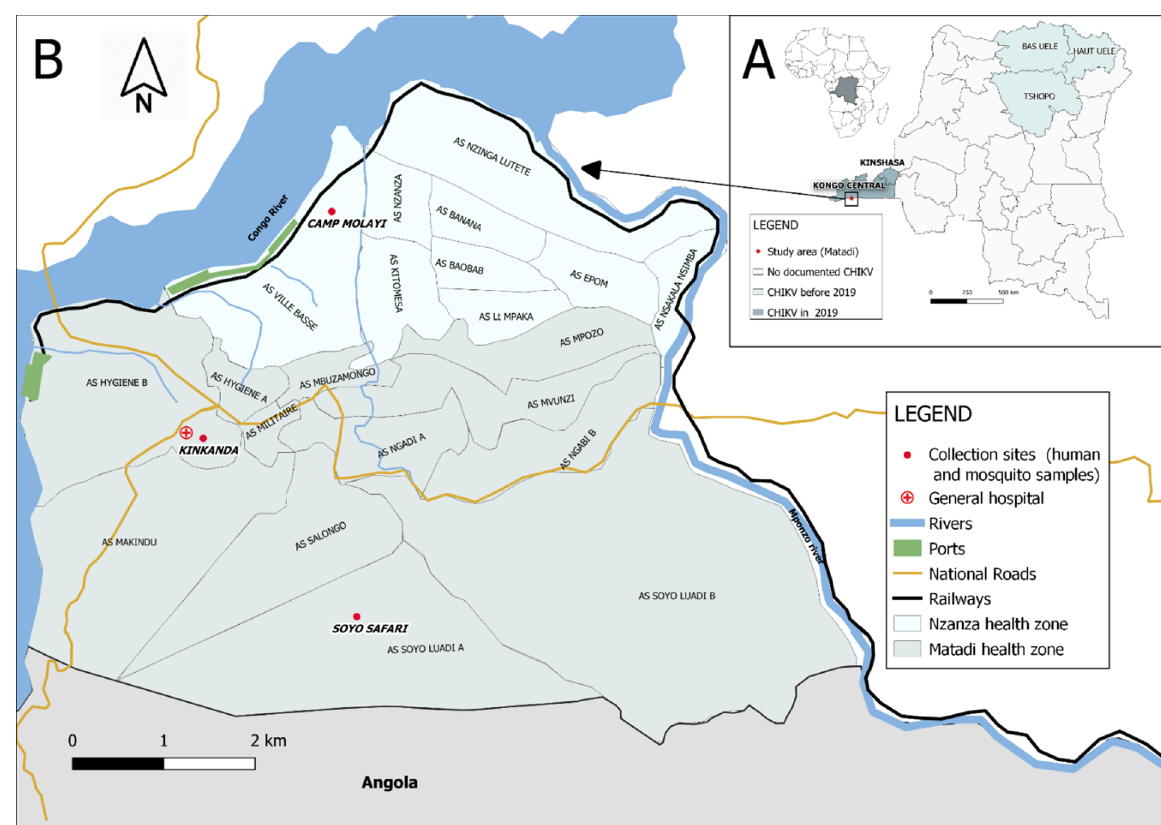
Figure 1. ( A ) Map of the Democratic Republic of the Congo (DRC) indicating the provinces where chikungunya virus outbreaks have occurred up to 2019 (including the Matadi study area indicated with the red dot). ( B ) Map of Matadi (study area) in Kongo Central province in DRC. The red dots indicate the places where human and mosquito samples were